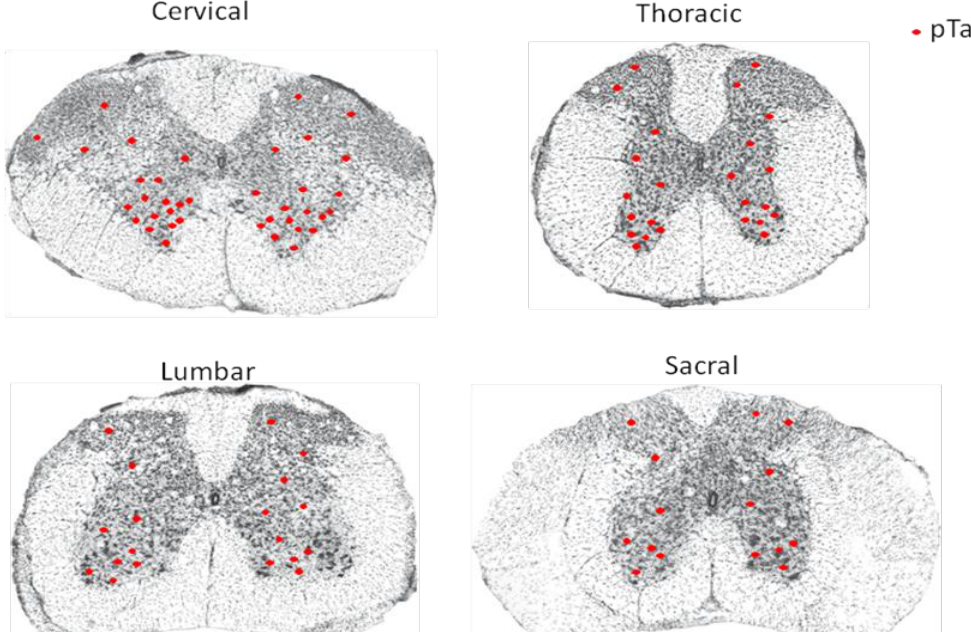
Figure 1. Schematic diagram summarizing the distribution of hyperphosphorylated tau protein (pTau) in each segment of the spinal cord from Alzheimer’s disease (AD) patients based on descriptions from References [13–25]. The red dot indicates pTau .